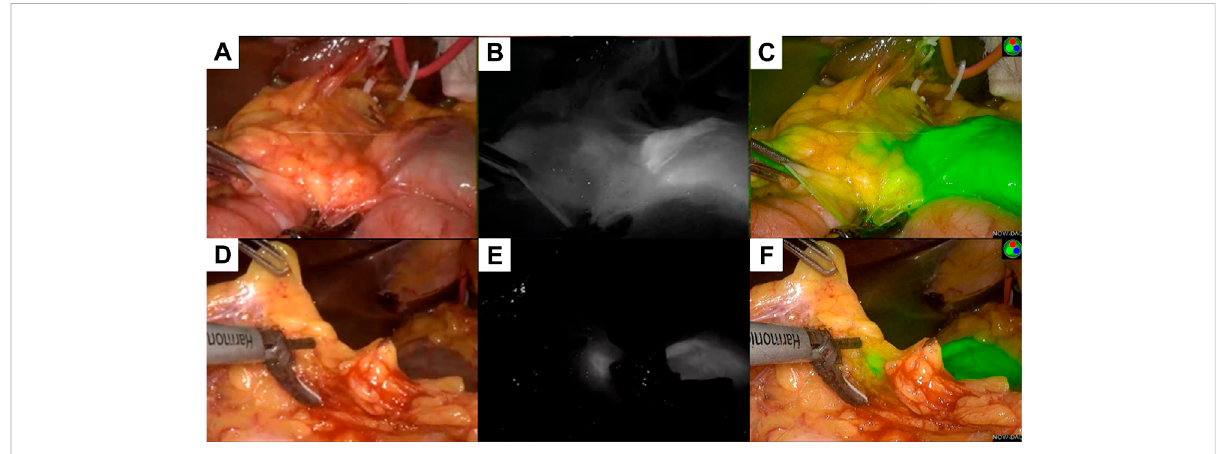
FIGURE 5 Different mode of thelesion under fl uorescence laparoscopy during theradical operation. (A) showed thenormal modeof aprimary lesion, (B) showed theblack and white modeoftheprimary lesion, (C) showed the fl uorescence modeof theprimary lesion; (D) showed thenormal modeofa lymph node lesion, (E) showed the black and white mode of the lymph node lesion, (F) showed the fl uorescence mode of the lymph node lesion.